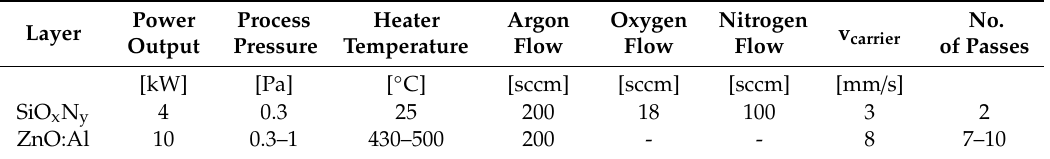
Table 1. Deposition parameters of the SiO x N y and the ZnO:Al layer. v carrier is the velocity of the carrier while passing the target during dynamic